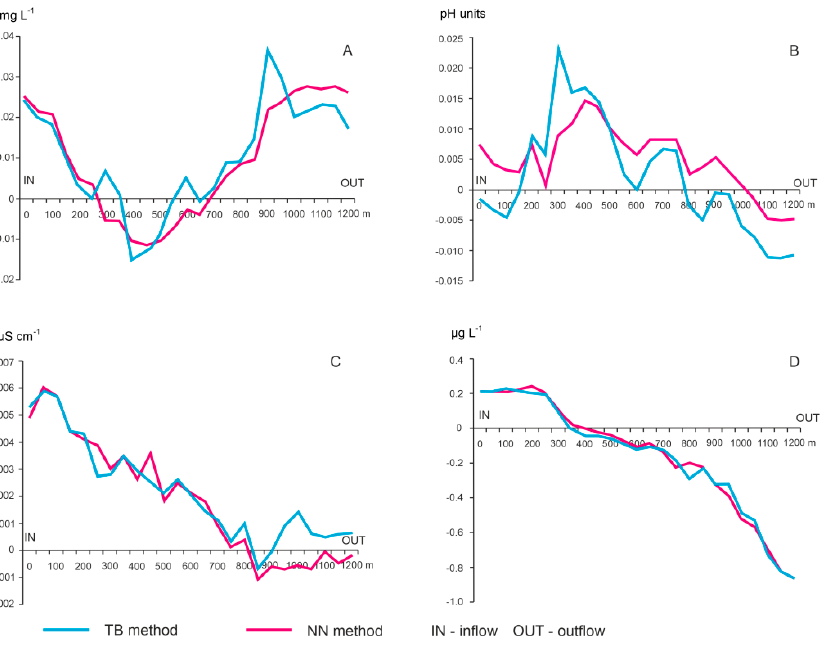
Figure 4. Variability of the parameters along lake’s inflow–outflow transect: ( A ) DO, ( B ) Ph, ( C ) EC, ( D ) Chl-a.